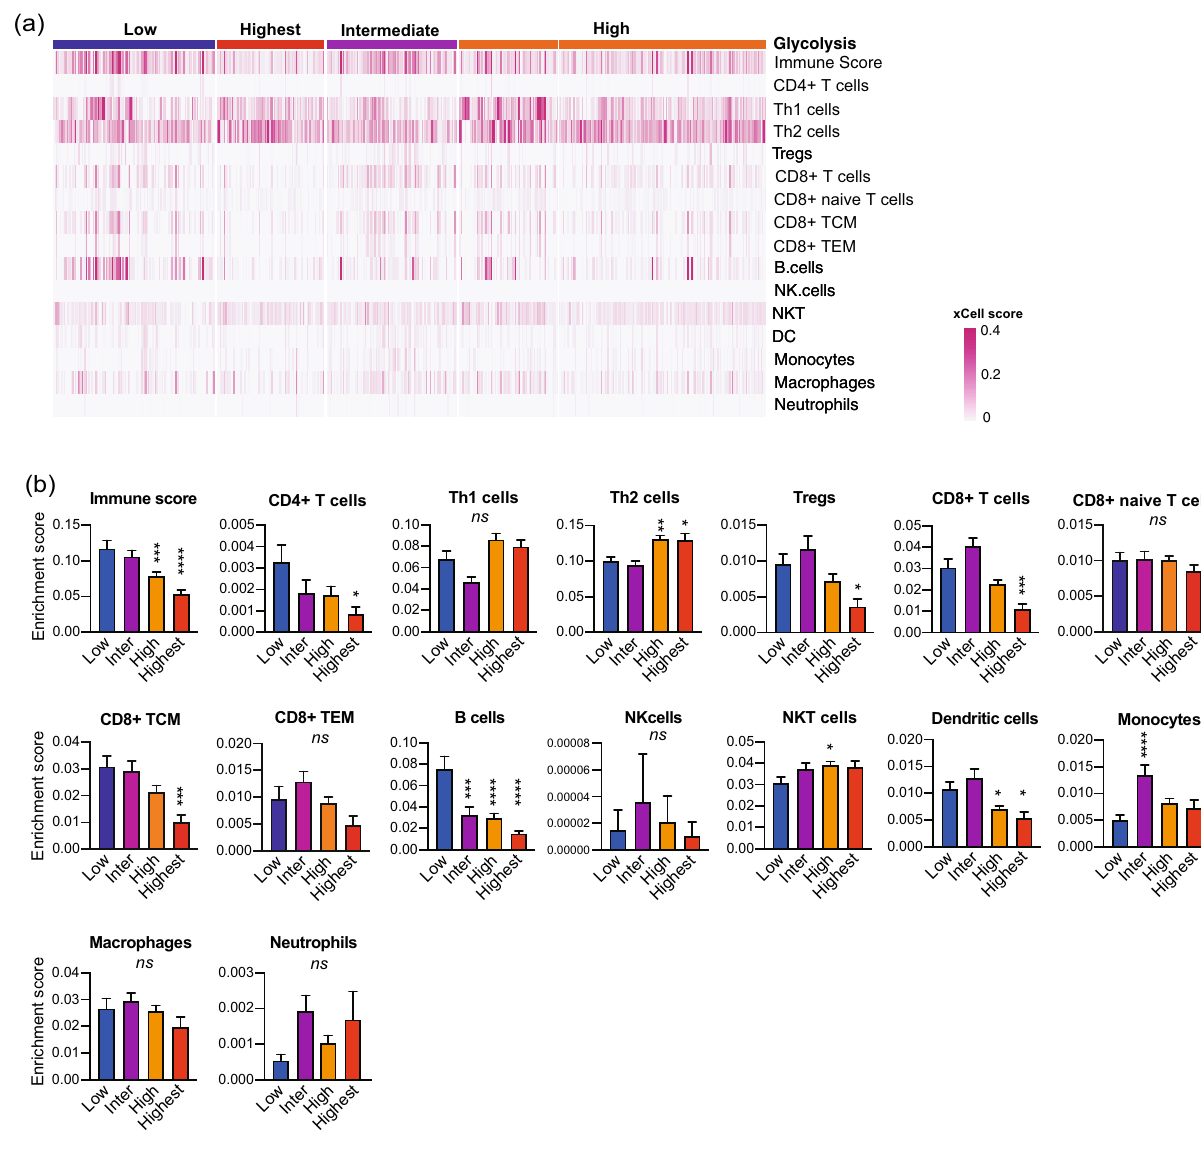
Figure 3. Glycolytic activity negatively correlated with immune cell enrichments that facilitate anti-tumor immunity. ( a ) Heat map of immune cell enrichment scores in 520 patients with HNSCC obtained from TCGA database. The enrichment scores of basic immune cell types were calculated using the xCell tool. ( b ) Bar graphs of immune cell enrichment scores in the glycolysis groups shown in a. The enrichment scores in the glycolysis- intermediate, the glycolysis-high, and the glycolysis-highest group were compared to those in the glycolysis-low group. *, P < 0.05; **, P < 0.01; ***, P < 0.001; ****, P < 0.0001. HNSCC, head neck squamous cell carcinoma; TCGA, The Cancer Genome Atlas; TCM, central memory T cells; TEM, effector memory T